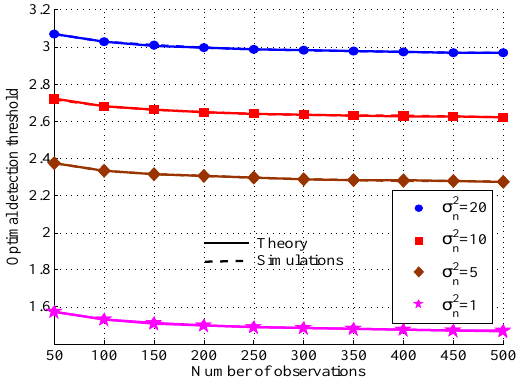
Figure 11. Optimal threshold τ using (A.3) and from G simulations vs. M for different σ 2 n